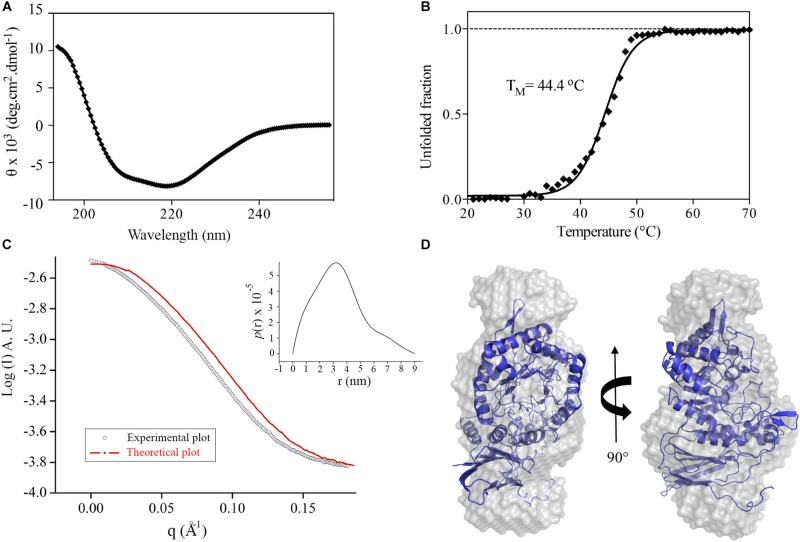
XacXynB secondary structure, stability and oligomeric state. (A) Circular dichroism spectrum of XacXynB. (B) Thermal denaturation profile of XacXynB monitored at 222 nm by circular dichroism spectroscopy. The midpoint transition temperature (TM) was calculated from the sigmoidal fit of the denaturation curve. (C) SAXS profile compared to the theoretical curve based on the crystallographic model of XacXynB. The pair-distance distribution function plot, P(r), is shown in the inset. (D) The crystallographic structure of XacXynB fitted into the SAXS envelope at two orientations.